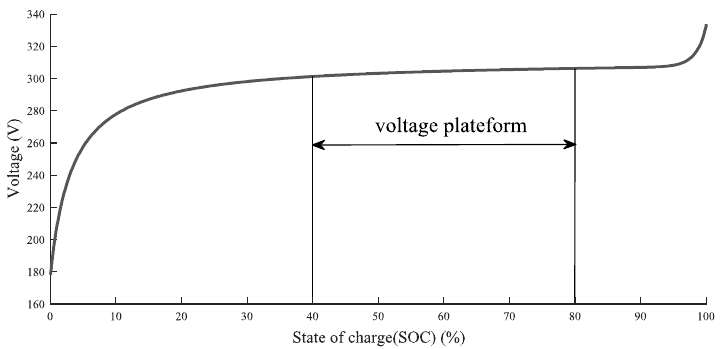
Figure 5. Voltage platform of a battery rated at 288 V and 14 Ah